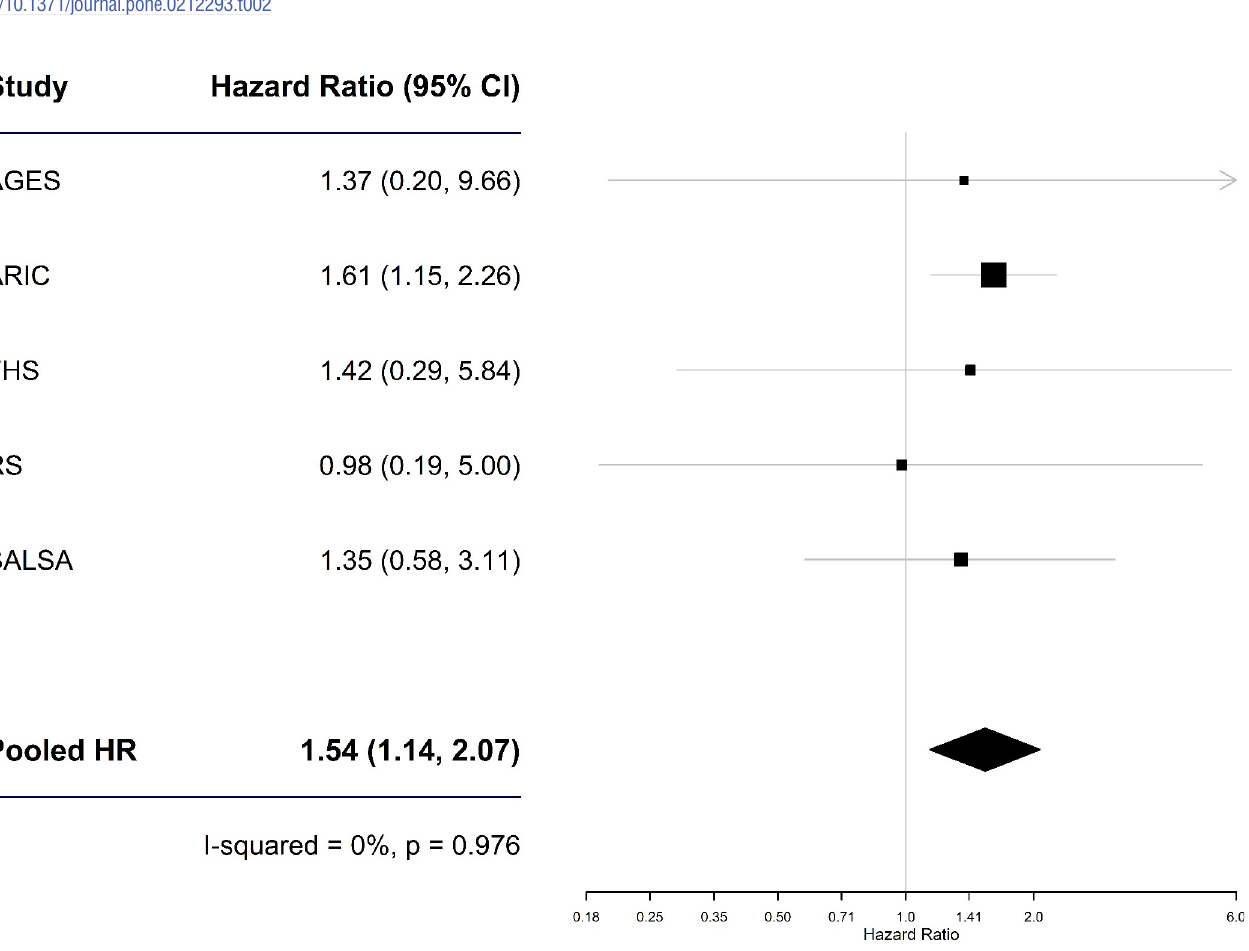
Fig 1. Association between insulin use and dementia risk. Comparison was made between users of insulin as a single drug or in combination with other diabetic drugs and non-users of insulin.